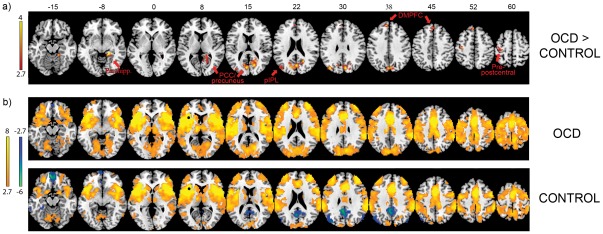
Connectivity with left anterior insula.a) OCD patients exhibited greater connectivity than controls between the left anterior insula seed and default mode network regions including parahippocampus, posterior cingulate cortex (PCC)/precuneus, posterior inferior parietal lobule (pIPL), and dorsomedial prefrontal cortex (DMPFC). Patients also showed greater connectivity with pre-postcentral gyrus. Numbers above images represent z-coordinate (MNI format) of axial slices. Images displayed at p<.005, corrected across whole-brain gray matter at p<.05, b) Connectivity maps with left anterior insula for both groups, displayed at p<.005 with 10 contiguous voxels. Black circles represent location of seed. Color bars represent t-scores.